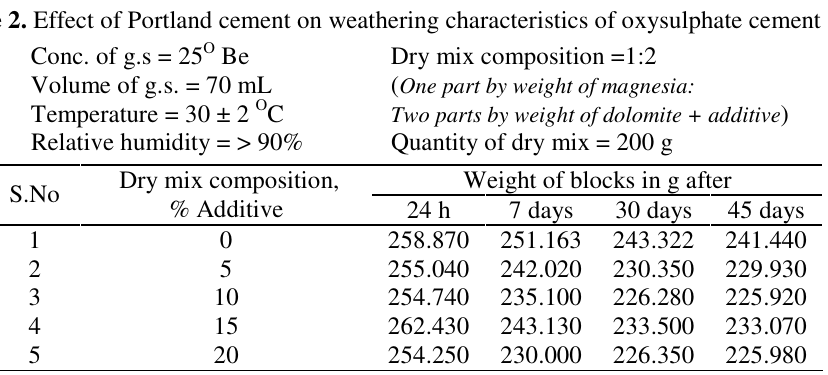
Table 2. Effect of Portland cement on weathering characteristics of oxysulphate cement Conc. of g.s = 25 O